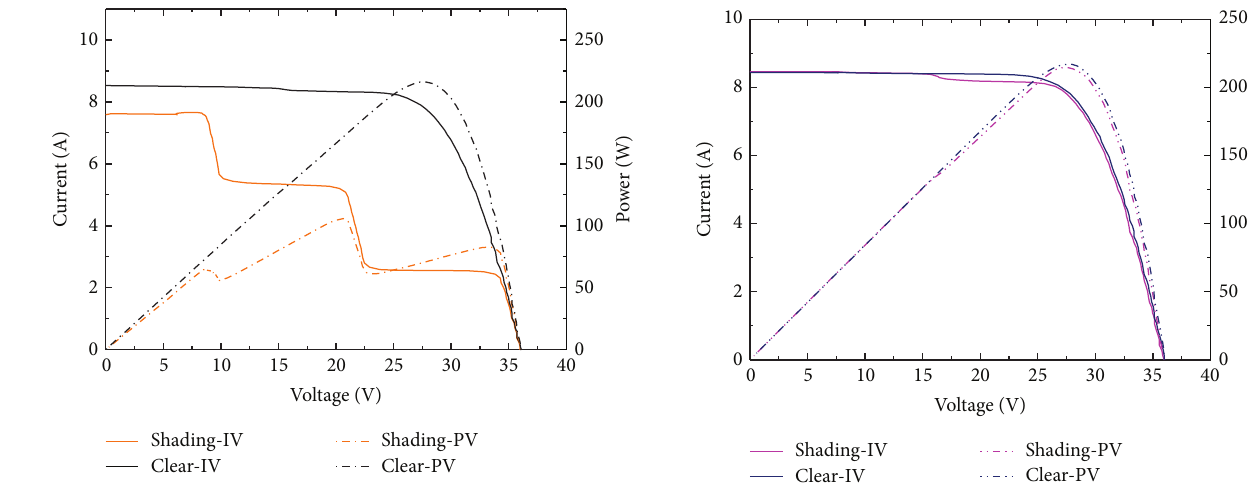
Figure 8: The I-V and P-V characteristics of the module before and after the bird droppings